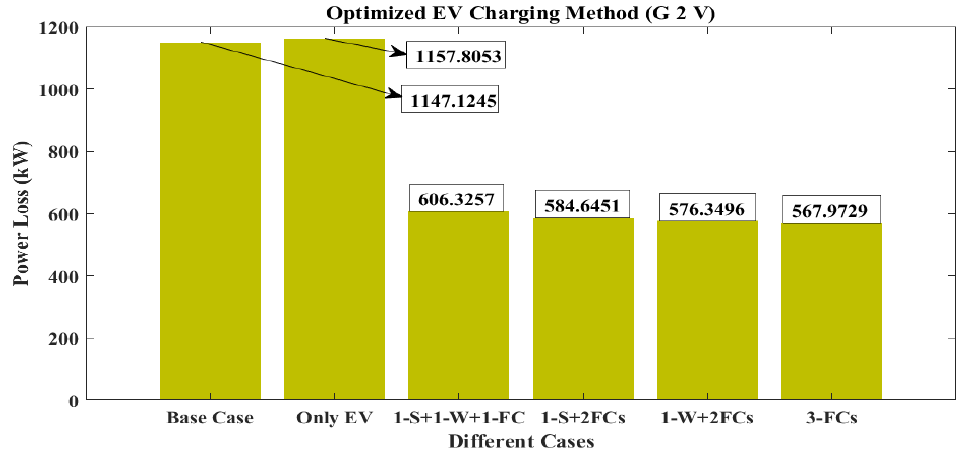
Figure 20. Optimized EV Charging method (G2V) P Loss with Different Cases.